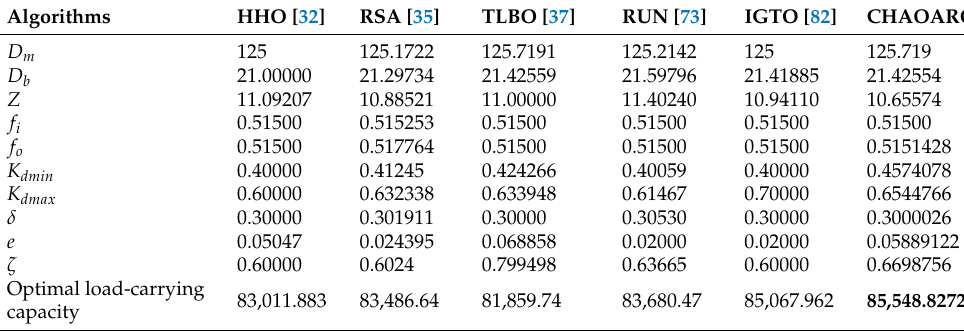
Table 16. Comparison results for rolling element bearing design problem.